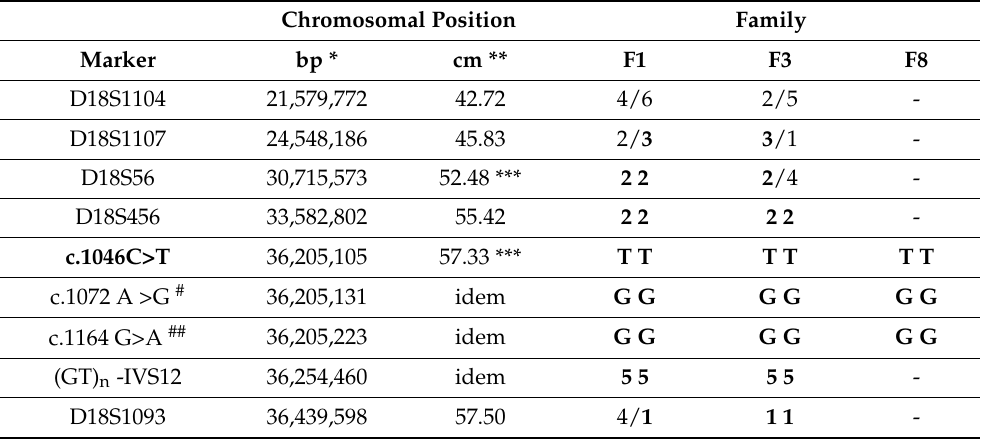
Table 3. Haplotype analysis of the polymorphic markers linked to the MOCOS c.1046C>T variant in three Yemenite-Jewish